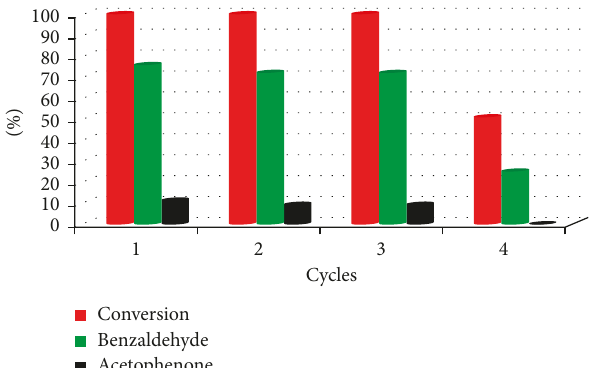
Figure 5: Reusability of the catalyst in oxidation of styrene. Reaction conditions: C4 catalyst (0.02 g); H solvent, acetone; reaction time, 24 h. Yields are determined by GC using dodecane as an internal standard.